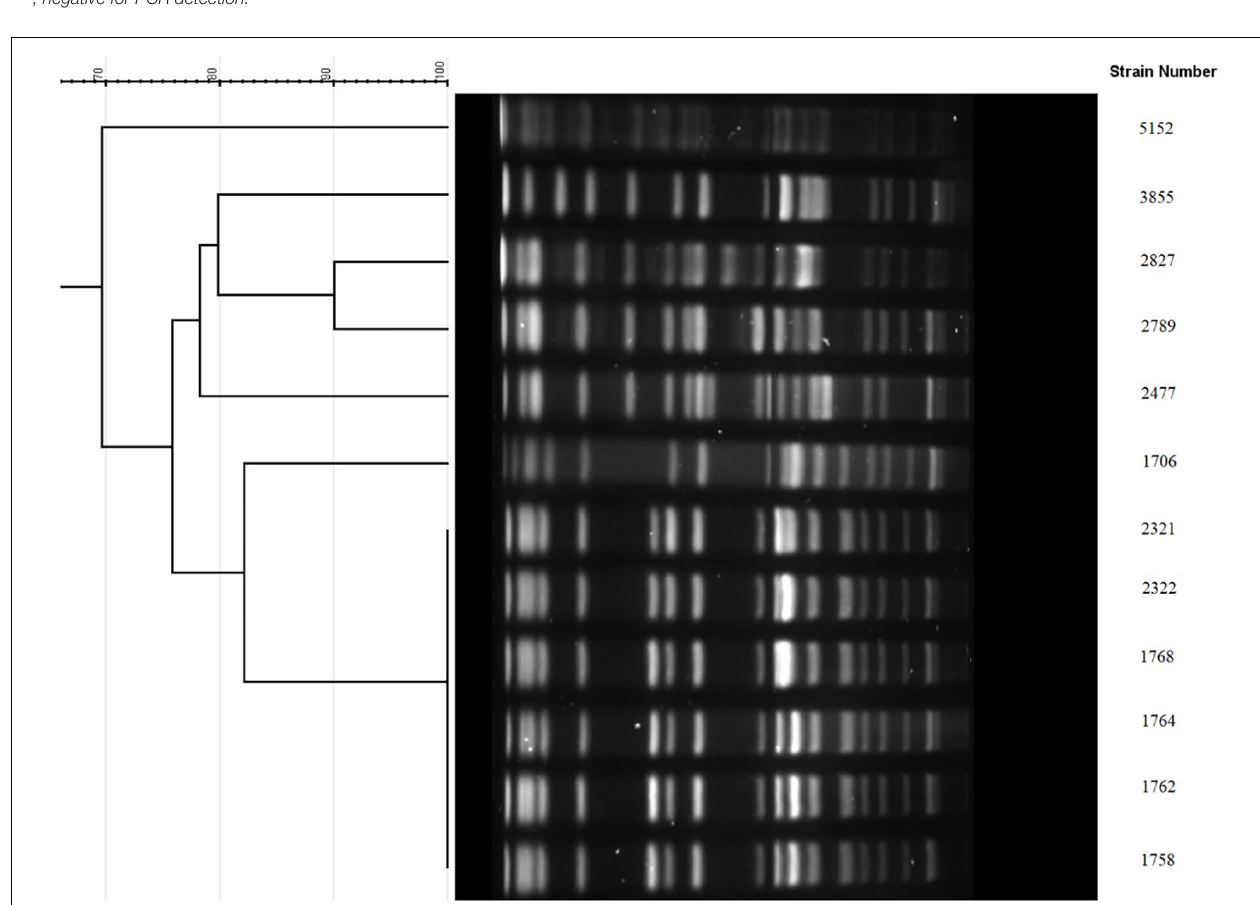
FIGURE 1 | PFGE cluster analysis of the 12 KPC-KP with reduced susceptibility to ceftazidime-avibactam. 1758, 1762, 1764, 1768, 2321, and 2322 were from Beijing sharing the same PFGE pattern. 2477, 2789, and 2827 were from Kunming, among which 2789 and 2827 were highly homologous ( > 90%). 1706 and 5152 were from Guangzhou. 3855 was from